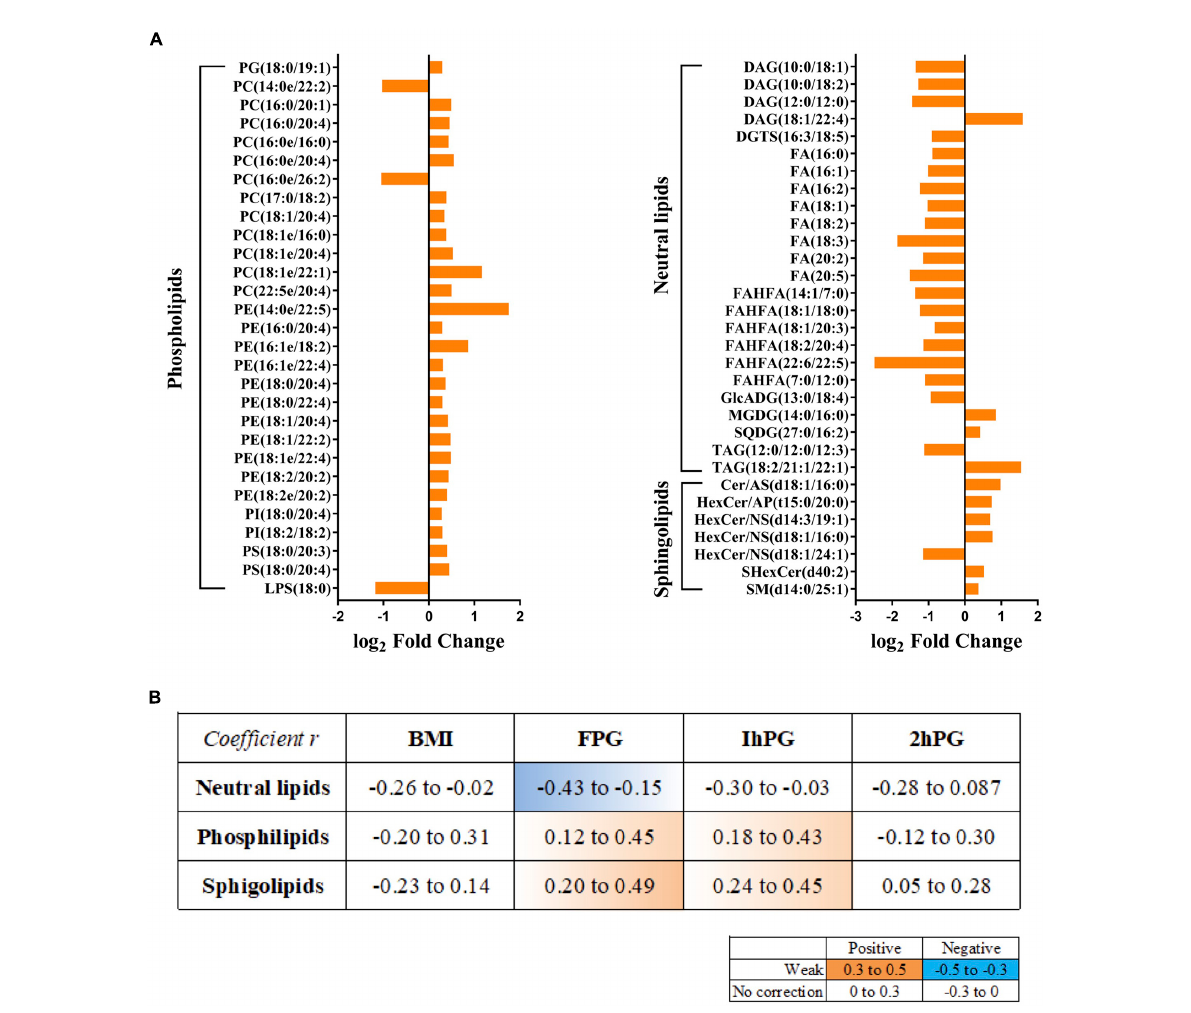
FIGURE3 Lipids changes in breast milk correlate with maternal glucose. (A) Fold changes of significantly altered lipids between GDM group and NC groups. (B) Correlations between GDM related lipids and maternal clinical parameters. Orange color indicates a positive correlation, and blue exhibits negative